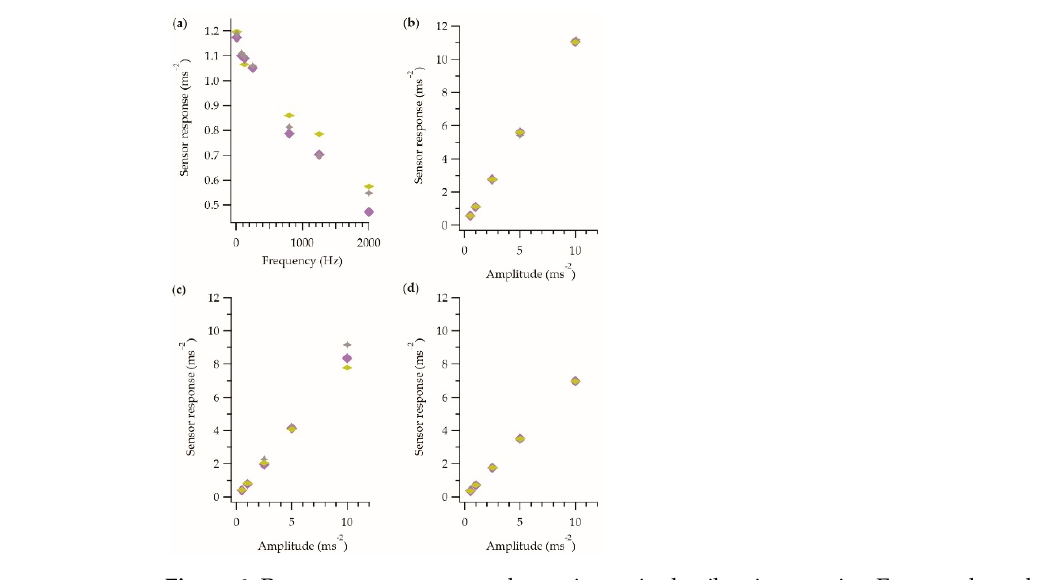
duced by factors such as variations in the placement of the yarn onto the vibration stage.